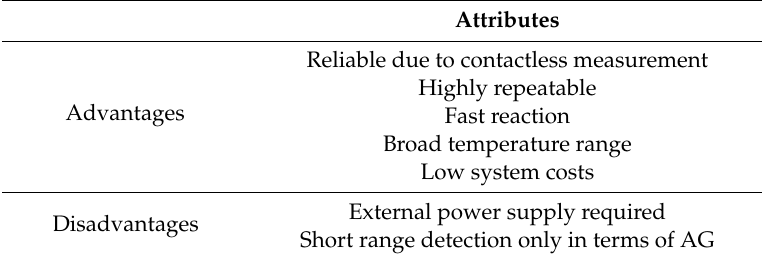
Table 3. Advantages and disadvantages of the Hall effect sensor technology.